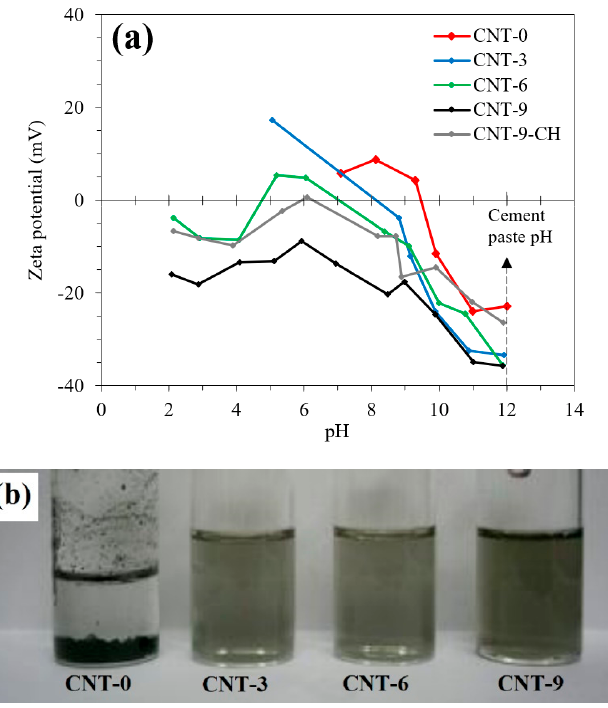
Figure 1. Zeta potential ( a ) and sedimentation ( b ) of the carbon nanotubes (CNT) with different exposure times to H 2 SO 4 /HNO 3 solution.